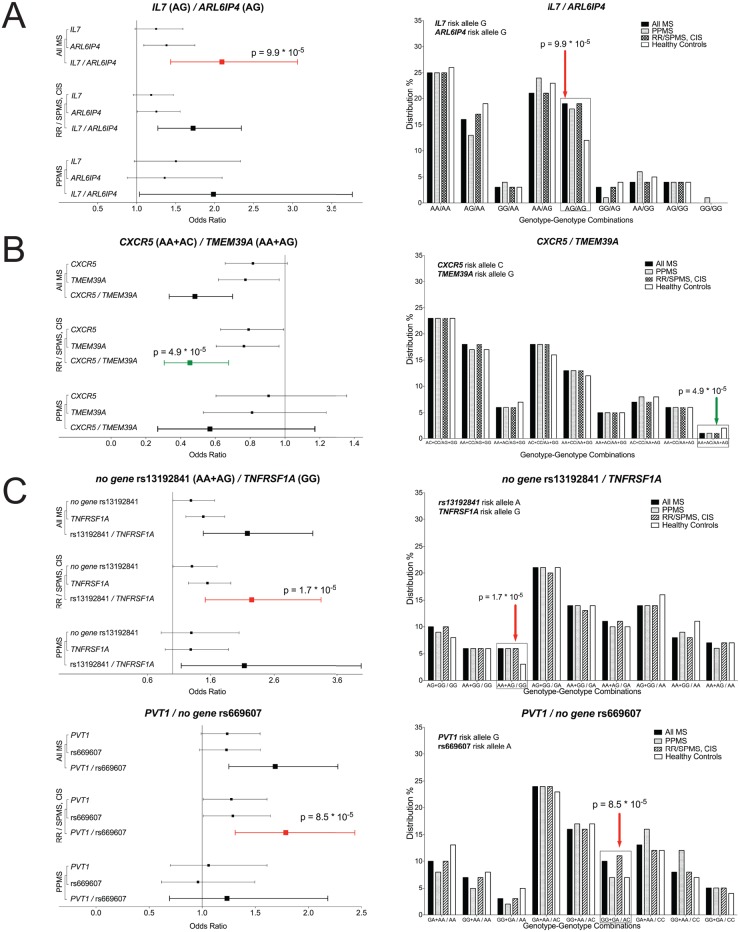
Forest Plots and genotype-genotype distributions for significantly associated combinations.Left-hand side: Forest plots showing the odds ratios (OR; incl. 95% C.I.) for the significantly associated genotype-genotype combinations, including the contributing single genotype ORs. Lead genotype-genotype combinations have been listed and colored for ORs with a p-value <1*10–4, red = OR>1, green = OR<1. ORs have been listed for all tested cohorts/disease courses (All MS; RRMS, SPMS and CIS; PPMS) in order to distinguish disease course specificity. The contributing genotype is stated in brackets behind the corresponding heading gene name. On the right handed side, the percentage distribution of each genotype-genotype combination in the given cohort is presented as a bar chart. The significantly associated genotype-genotype combination from the left handed graphic is highlighted via frame and colored arrow; red = OR>1, green = OR<1. A, B, C: correspond to significantly associated genotype-genotype combinations obtained from models A, B and C.